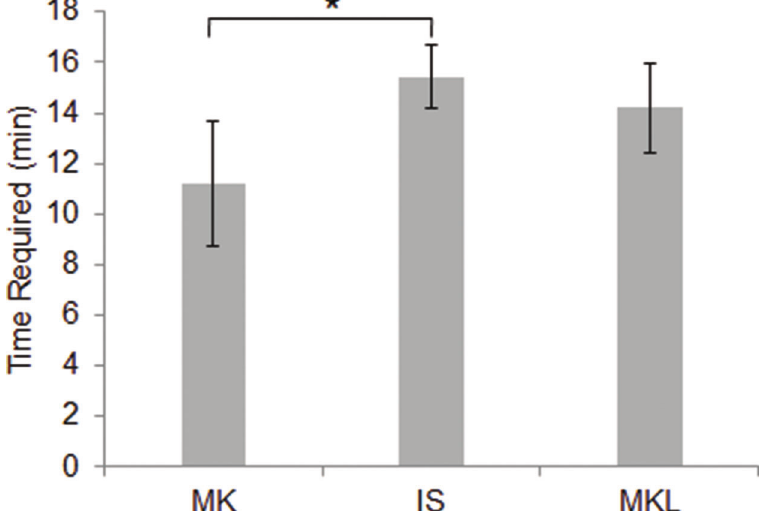
Figure 5 - Times required for different suture techniques. Less time was required for the MK technique (11.2 ± 2.5 min) than for the IS technique. There was no significant difference between the times required for the IS and MKL techniques. * p o 0.05 vs .